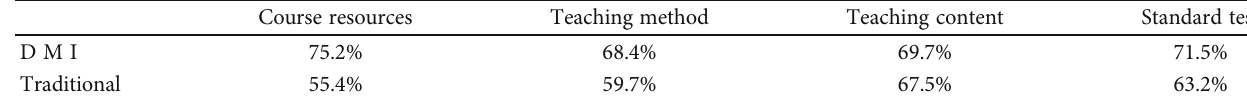
Figure 2: Analysis of problems existing in the teaching method of level teacher. Table 4: Comparative analysis of Taekwondo teaching.